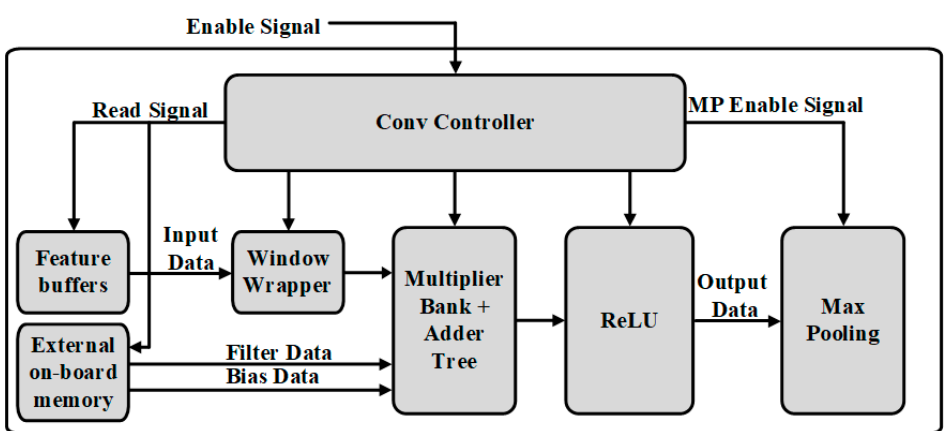
Figure 4. Overall architecture of the convolution layer.